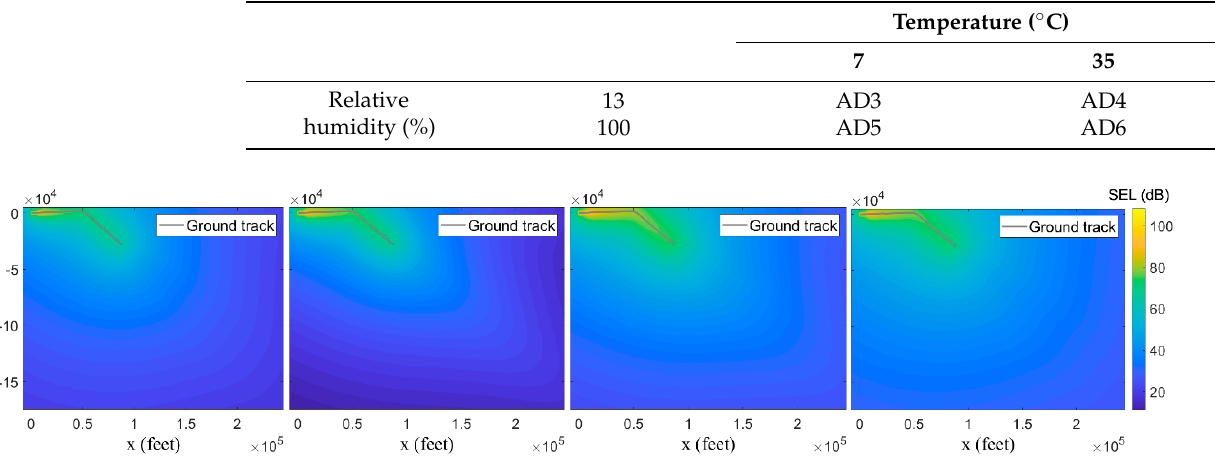
Table 3. Yearly extrema in atmospheric conditions recorded in Hong Kong (sea level pressure) and meteorological scenarios considered for the four flights.